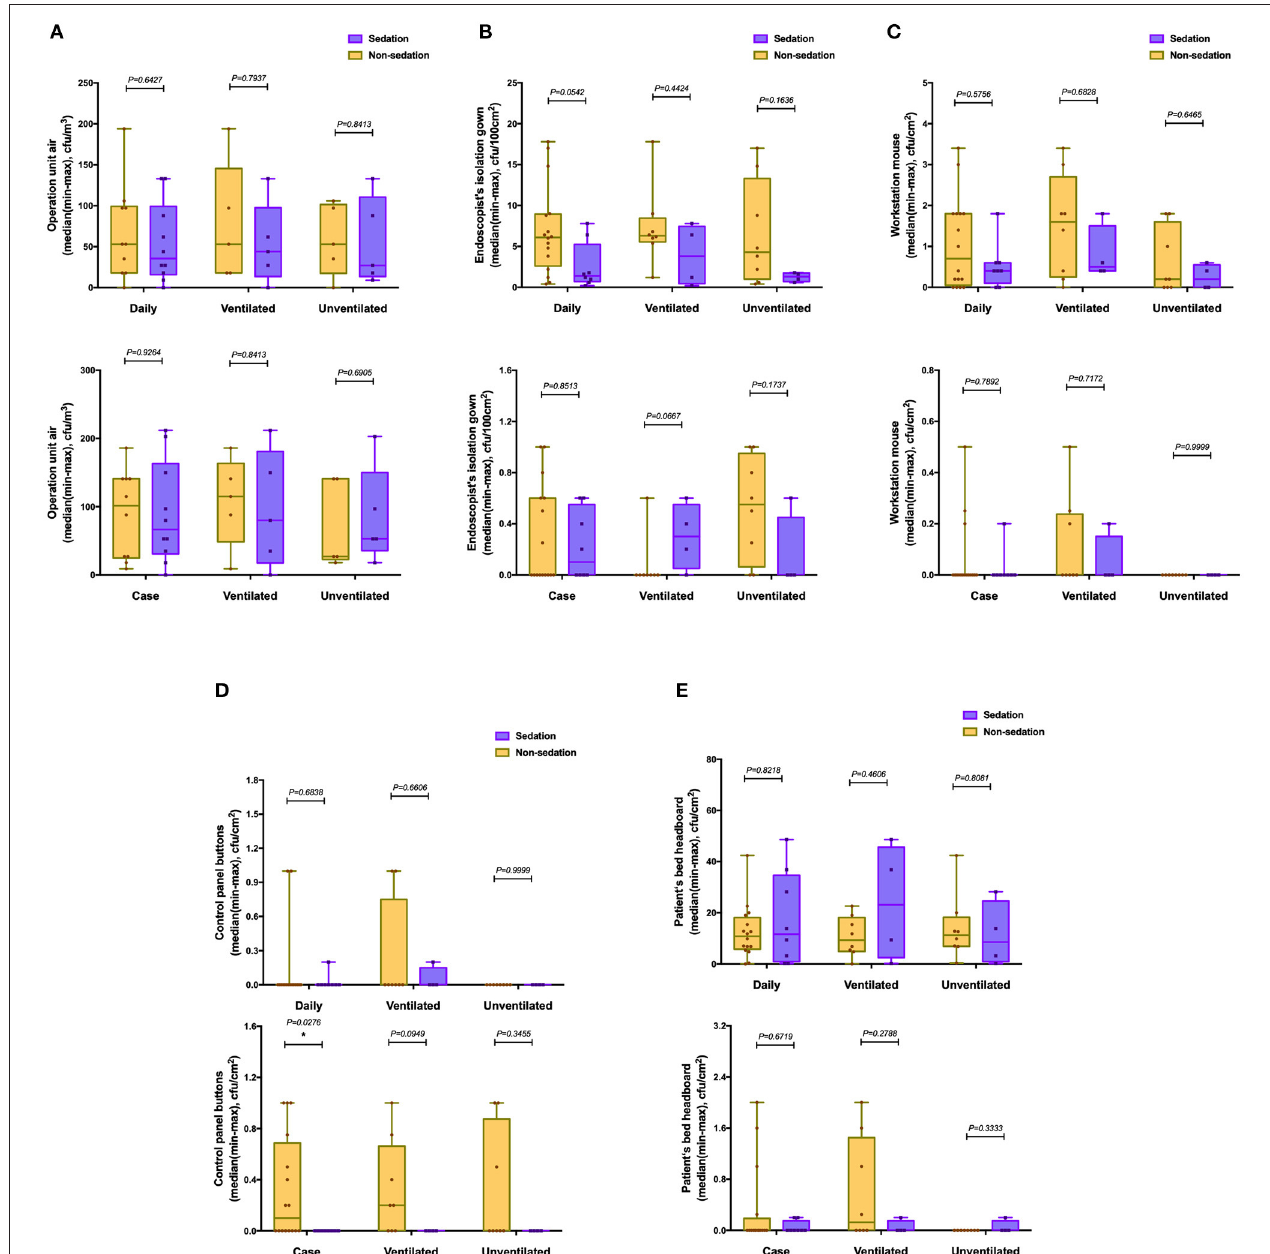
FIGURE 3 | The number of culture samples in the level of CFUs for the surface of the endoscopy unit between ventilated and unventilated rooms. (A) operation unit air; (B) isolation gown of the endoscopist; (C) workstation mouse; (D) control panel buttons; and (E) bed head of the patient. * p <